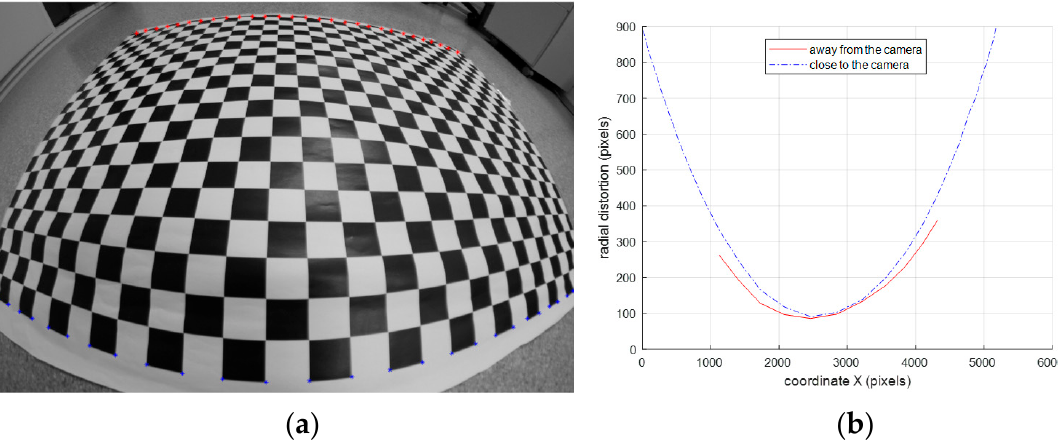
Figure 1. ( a ) Image of a planar checkerboard used as calibration template. The checkerboard is under perspective to notice the radial distortion variation when the camera-object distance changes. ( b ) Figure of the radial distortion profile depending on the camera-object distance. Solid red line represents radial distortion when object is away from the camera appearing at top of Image 1a. The blue dashed line represents the radial distortion when the object is close to the camera appearing at the bottom of the Image 1a.